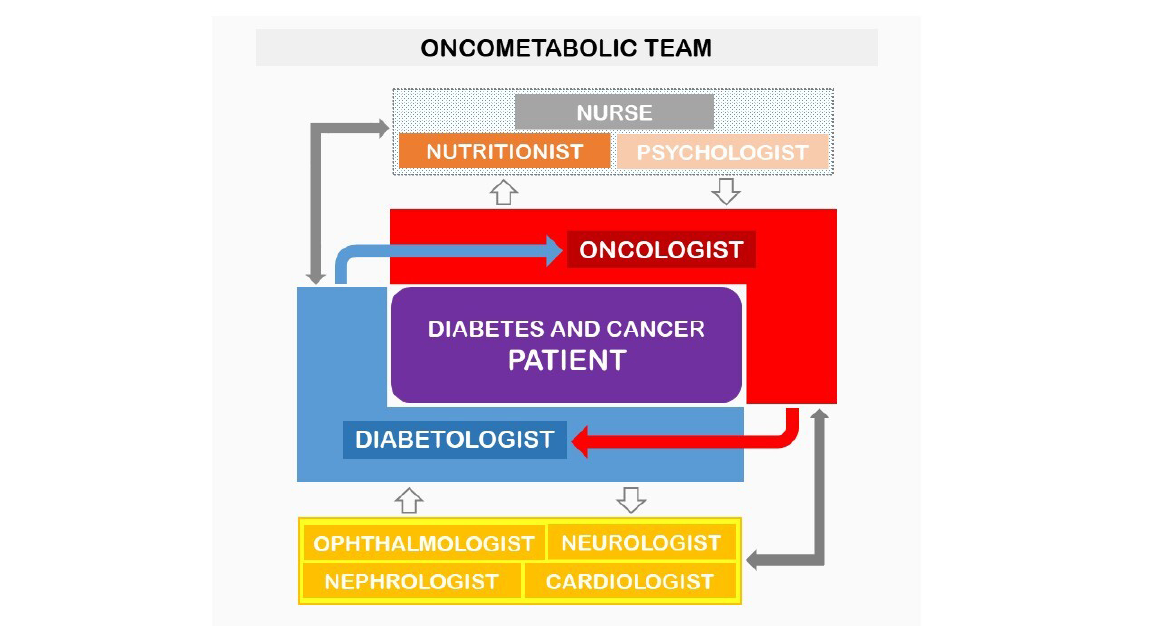
Figure 1. Schematic representation of the oncometabolic network for the care of patients with diabetes and cancer. Diabetologist and oncologist, the leading figures of the oncometabolic, multidisciplinary team (central part of the figure), collaborate to address the diagnostic and therapeutic course of these patients and manage the connection with the other specialists involved (top and bottom of the